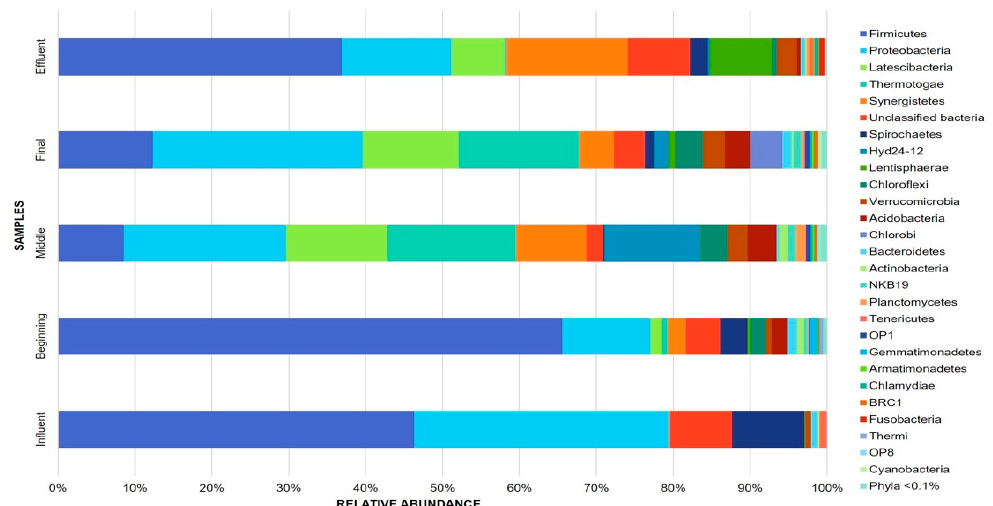
ff erent sampling sites of the